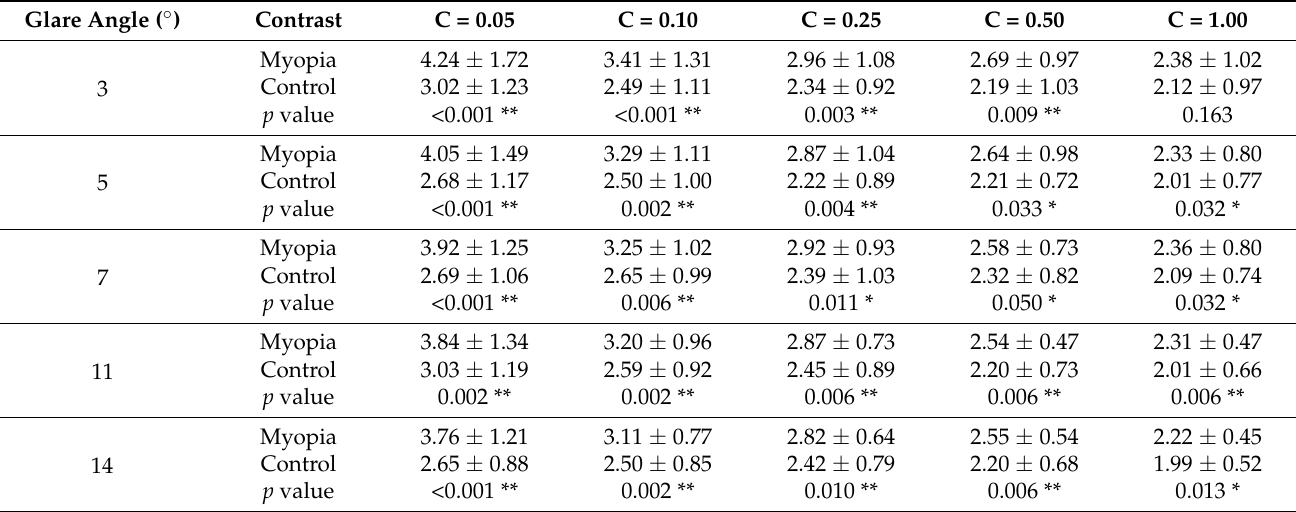
Table 2. PSRT (mean ± 1 std) in seconds for the myopic and control group and the p value obtained in the Mann–Whitney